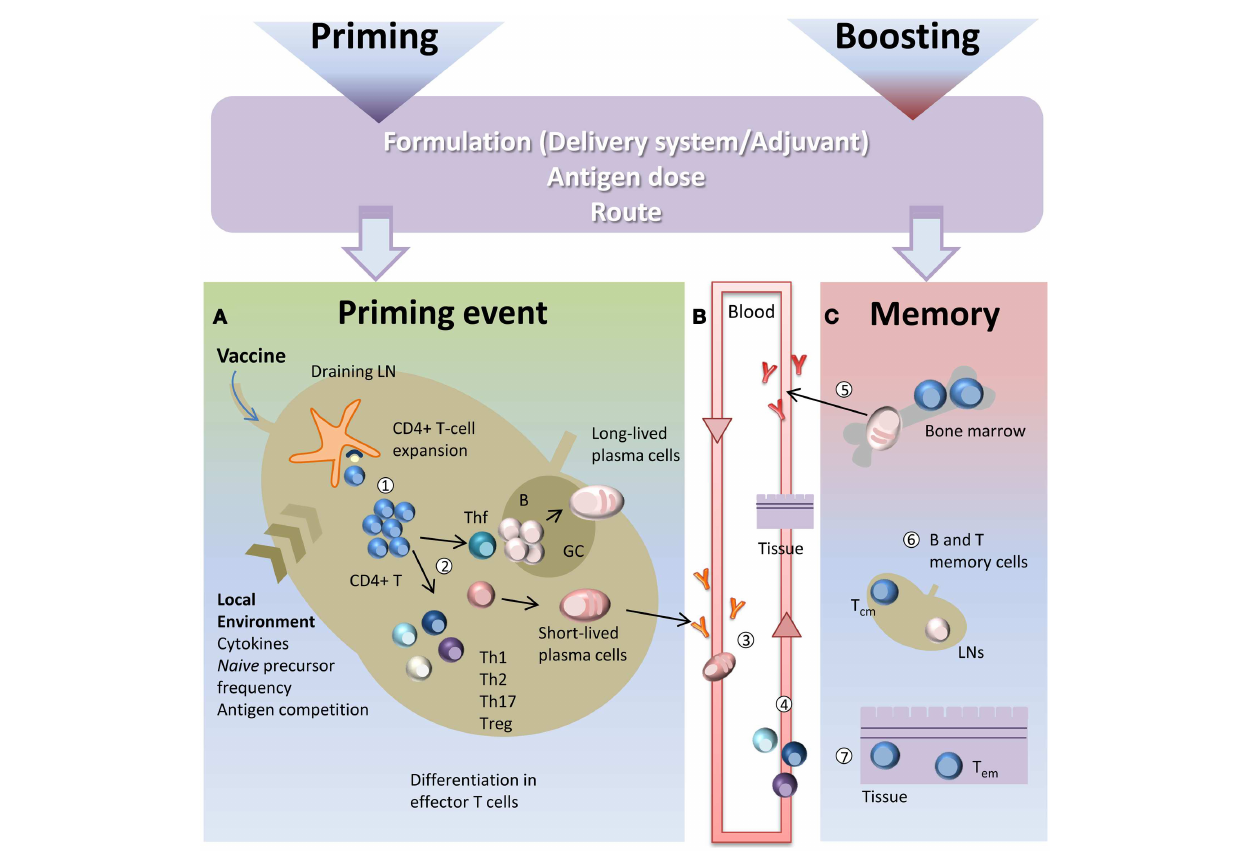
antibodies produced by short-lived plasma cells during the extra-follicular reaction, appear at low levels in the serum within a few days after immunization (3). EffectorTh1,Th2, andTh17 subpopulations exit the LN and through the blood disseminate toward other LNs and toward the inflamed tissue (in this context, the site of vaccine inoculation) where exert their effector function (4). (C) The long-lived plasma cells exit the LN at the end of the GC reaction and migrate to survival niches mostly located in the bone marrow (BM) where they survive through signals provided by supporting stromal cells and continue to release hypermutated antibodies (5). Another fraction of B cells, matured during the GC reaction, develop a memory phenotype and disseminate into the extra-follicular areas of the LN where they persist as resting cells until booster immunization or pathogen encounter (6). MemoryT cells traffic throughT cell areas of secondary LNs and BM (Tcm) (6), or localize within tissue (Tem) (7). Booster immunization induces a rapid reactivation of memory B andT cells, with proliferation and differentiation into effector cells. Memory B cells mature into plasma cells secreting large amounts of high-affinity antibodies that may be detected in serum within a few days after